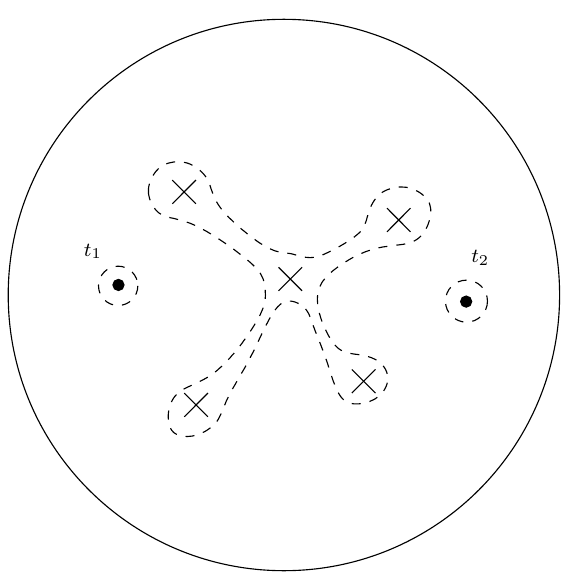
Figure 1 . The diagram of the contour pull in the t plane, attempting to pull the contour from infinity (solid line) to the other ramified points t 1 and t 2 (dashed line). However, there is an additional obstruction coming from the branch points in ( z ( t )) k/ ( n +1)+1 (images of z = 0), denoted by in the diagram, leading to the contour being deformed around these points and accompanying × branch cuts as well. Depicted above is the case n =